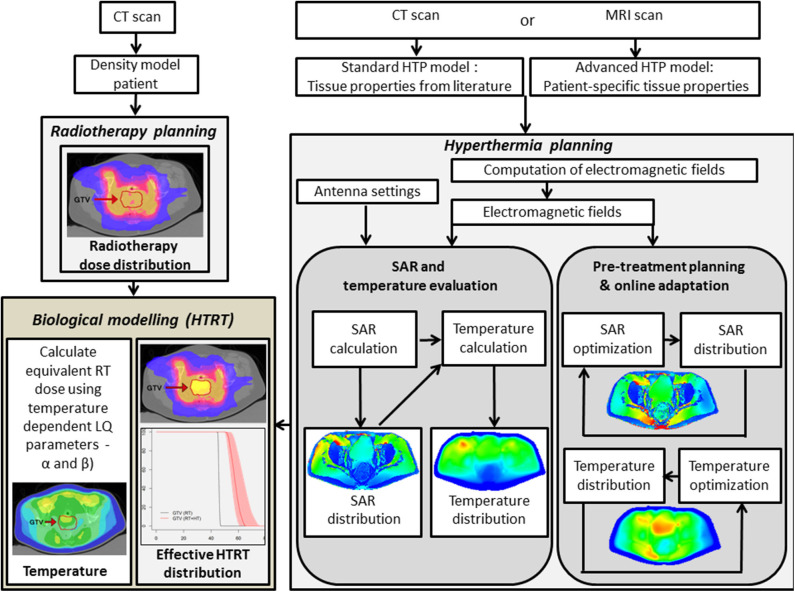
Flowchart depicting the hyperthermia treatment planning process, including SAR and temperature optimization, delivery, and online adaptive optimization. In addition, the hyperthermia and radiation therapy treatment plans are integrated in a joint platform using biological modeling with temperature-dependent linear-quadratic parameters α and β. RT, radiotherapy; HTP, hyperthermia treatment planning; HTRT, thermoradiotherapy; SAR, specific absorption rate. The images of HTP, RT, and HTRT plans have been modified and reproduced with permissions from Kok et al. (261) and van Leeuwen et al. (262).